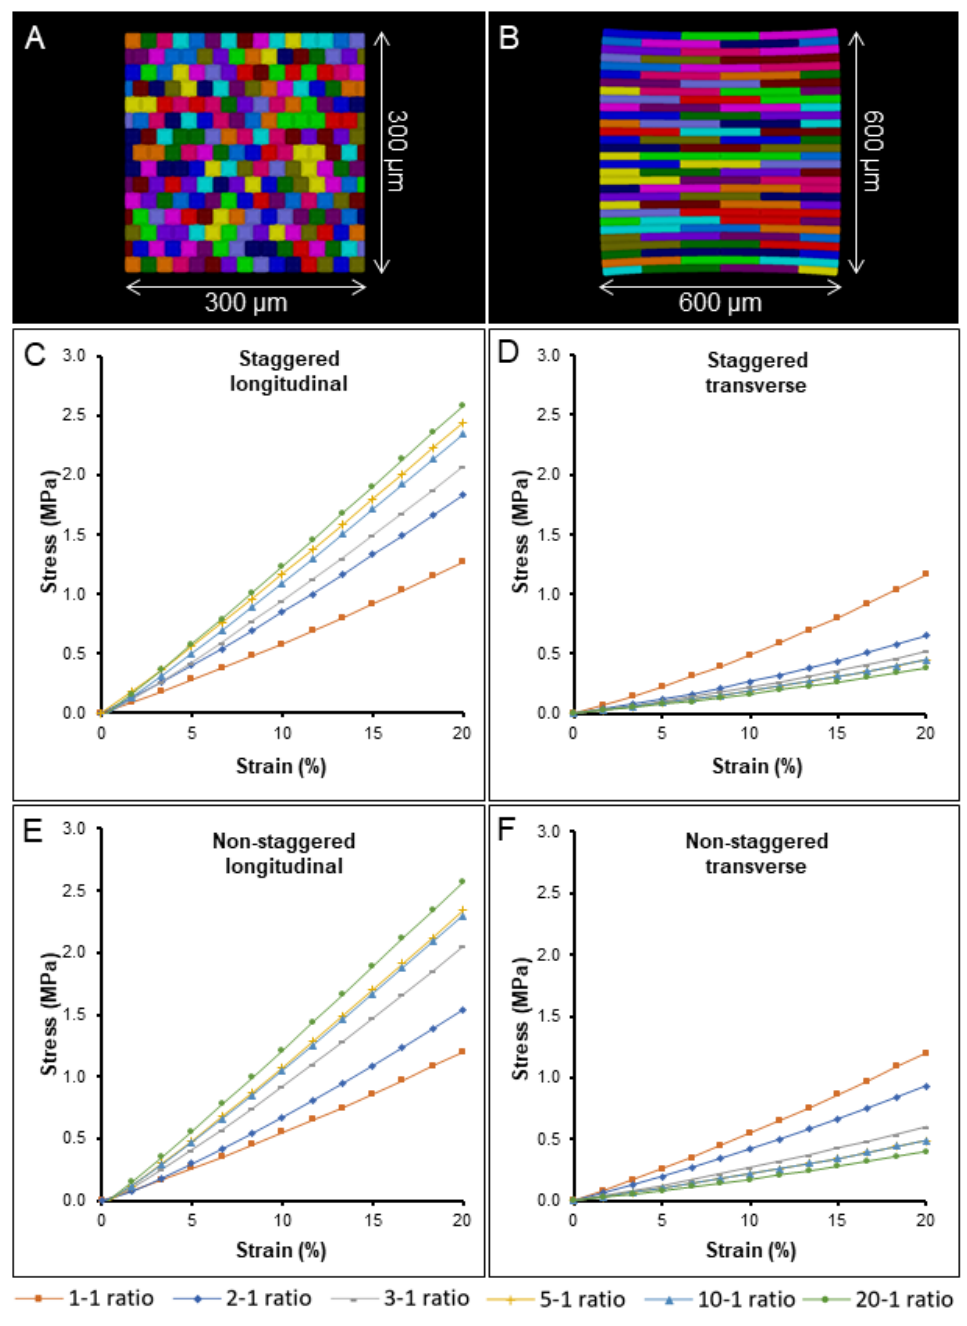
Figure 4. FEM simulation testing how cell–cell arrangement and cell ratio influences tissue stiffness. ( A , B ) Cell templates were generated in CellMaker from a cell aspect ratio of 1-1 ( A ) to 20-1 ( B ). The template used for the simulations was cut to a standard size of 300 × 300 um, except for the 20-1 cell aspect ratio of 600 × 600 um. Tissue consisting of cells arranged in staggered ( A – D ) or nonstaggered ( E , F ) patterns. Tissues stretched in longitudinal ( C , E ) and transverse ( D , F ) directions. The legend for cell aspect ratios is displayed in the figure.